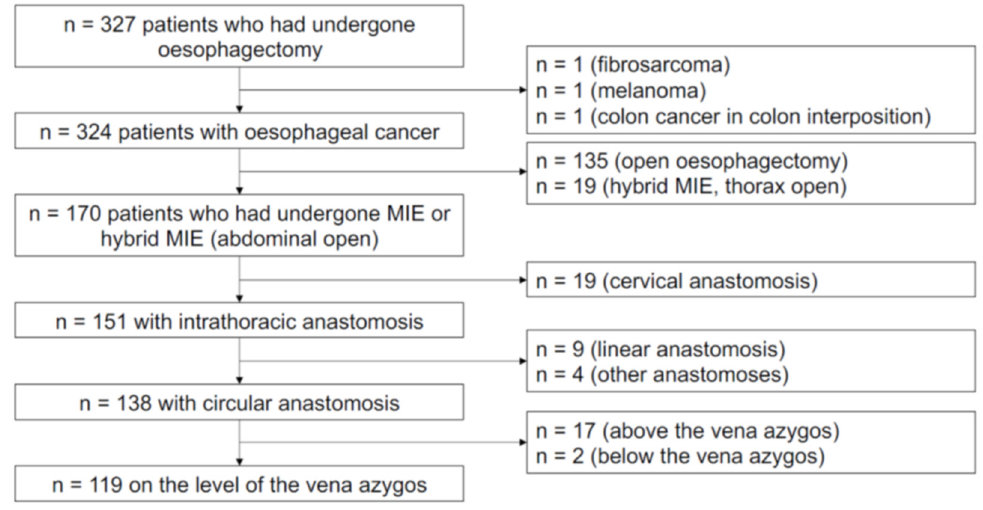
Figure 1. Study inclusion and exclusion criteria flow chart.